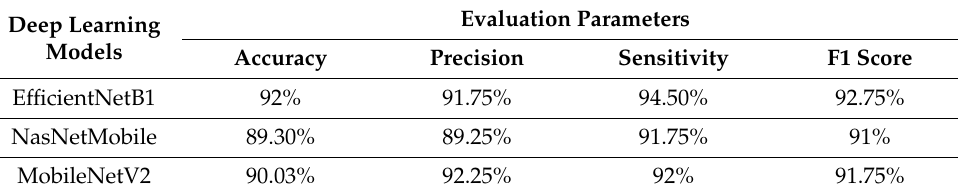
Table 3. Classification results using Strategy